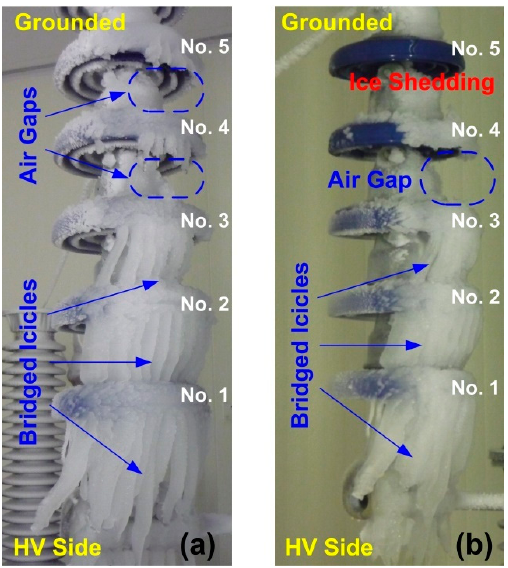
Figure 2. Surface condition of ice-covered outdoor insulators: ( a ) occurrence of ice shedding; ( b ) without the ice shedding.